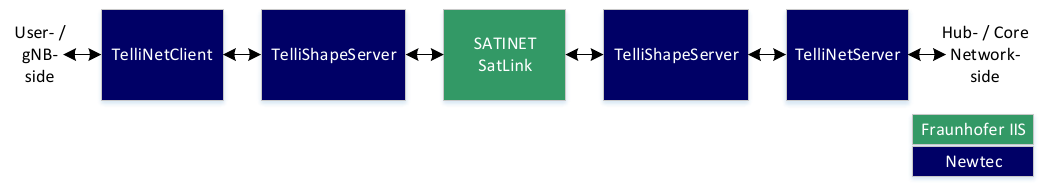
Figure 9. Satellite emulator high-level software